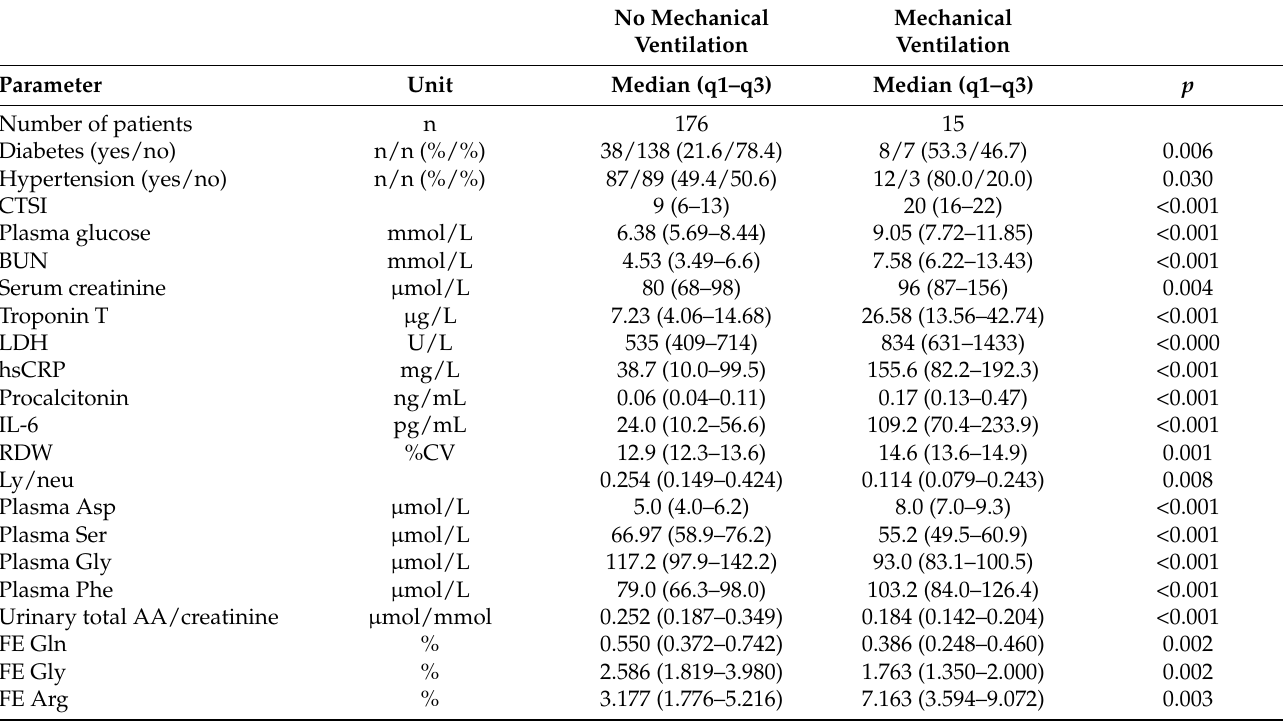
Table 3. Characteristics of study population by mechanical ventilation state. Only parameters with a significant difference between the groups are shown here. All other parameters are listed in Supplementary Table